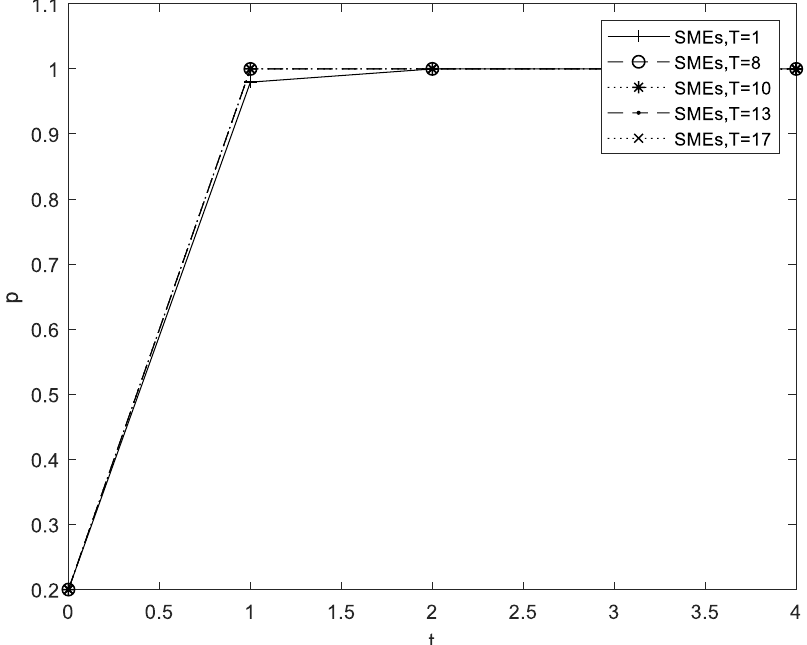
Figure 9. After a public health emergency, government regulatory agencies give more tax incentives T to SMEs that actively fulfill their corporate social responsibility in system evolution (About SMEs).